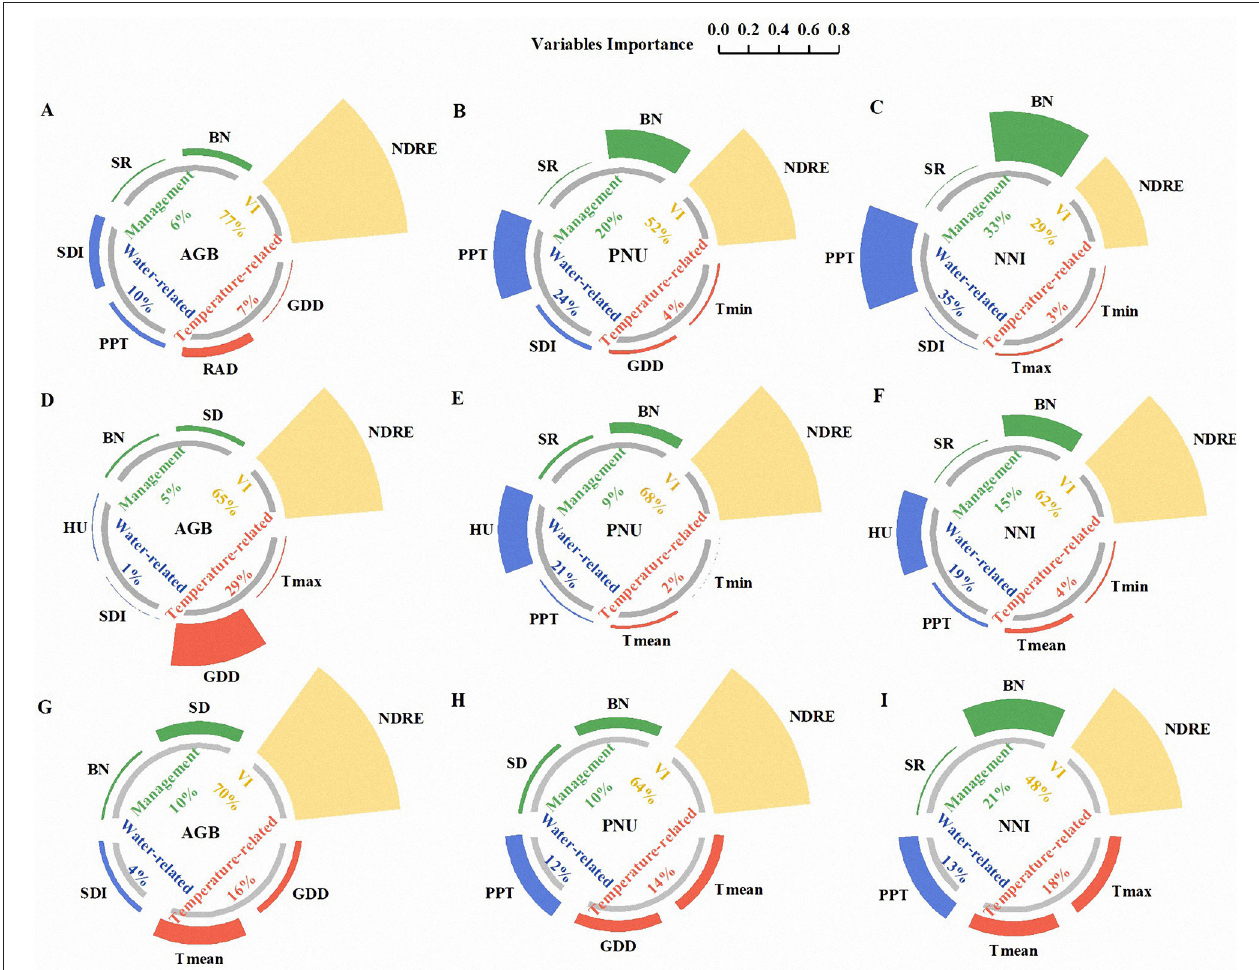
FIGURE 9 | The importance of variables of NDRE, climatic, and management factors for estimating the aboveground biomass, plant N uptake, and N nutrition index in agro-ecological zone 1 (A–C) , agro-ecological zone 2 (D–F) , and across two agro-ecological zones (G–I) . GDD, RAD, T max , T min , T mean , PPT, SDI, HU, SD, SR, BN, AGB, PNU, and NNI refer to growing degree days, solar radiation, seasonal maximum, minimum, and mean temperature, seasonal total precipitation, shannon diversity index, relative humidity, sowing dates, seeding rates, basal N, aboveground biomass, plant N uptake, and N nutrition index, respectively.